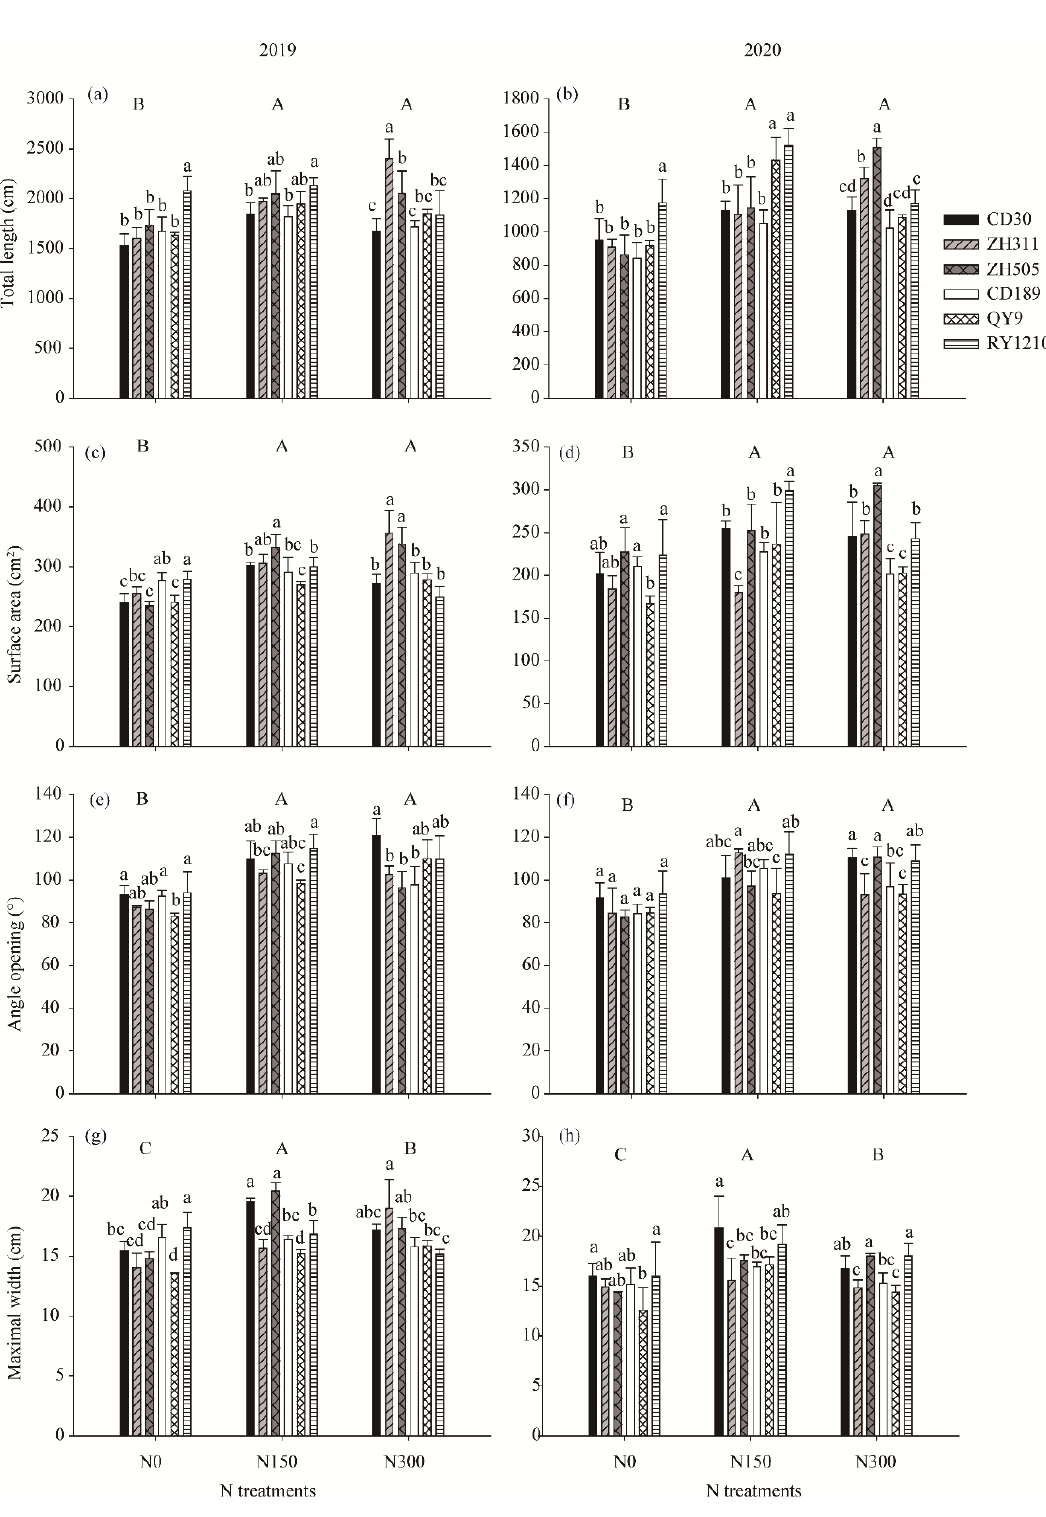
Figure 5. Root total length, surface area, angel opening, and maximal width of six maize cultivars under three N treatments in 2019 and 2020: ( a ) root total length in 2019, ( b ) root total length in 2020, ( c ) root surface area in 2019, ( d ) root surface area in 2020, ( e ) root angel opening in 2019, ( f ) root angel opening in 2020, ( g ) root maximal width in 2019, ( h ) root maximal width in 2020. Bars indicate standard error. Different lower case letters indicate significant differences at p < 0.05 among the cultivars in the same N treatment. Different capital letters indicate significant differences among the N treatments. N